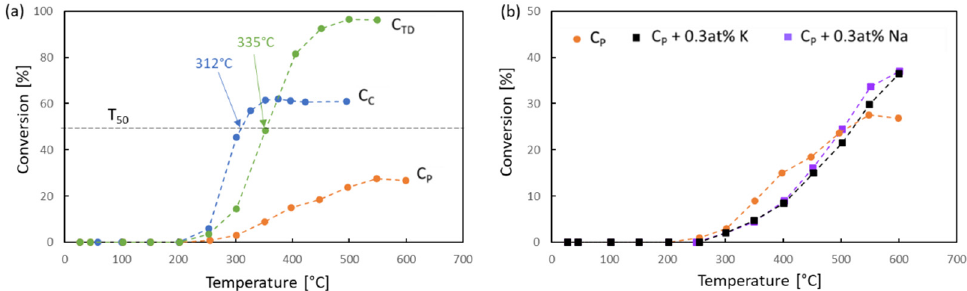
Figure 5. Activity of ( a ) different ceria supports in CO oxidation in the model stream, as well as ( b ) Na + - and K + -doped precipitated ceria.